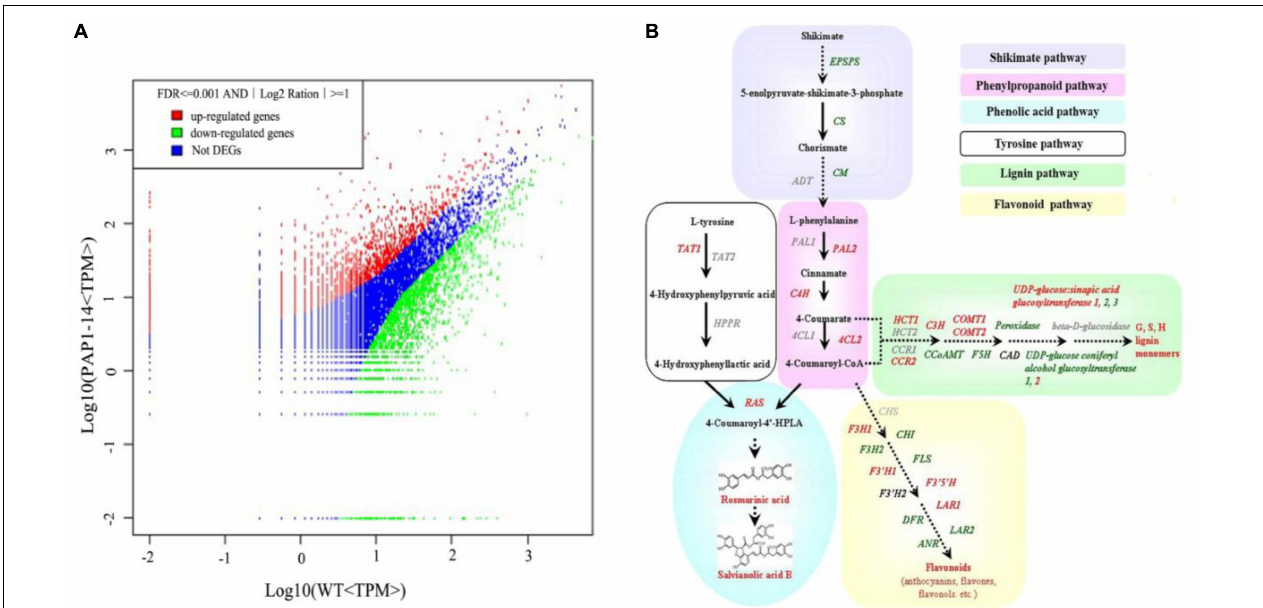
FIGURE 1 | Transcriptome response of Salvia miltiorrhiza to overexpression of AtPAP1 . (A) Comparison of gene expression between two libraries, with each normalized to one million tags. Red dots represent transcripts more prevalent in AtPAP1-14 library; green dots, those present at lower frequency in transgenic plants; and blue dots, transcript levels with no significant change. Parameters “FDR < 0.001” and “log 2 Ratio ≥ 1” were used as threshold to judge significance of differences in expression. (B) Proposed biosynthetic pathway for phenolics, beginning with core phenylpropanoid and tyrosine pathways, and leading to three major branch pathways: phenolic acid, flavonoid, and lignin (red, upregulated genes; green, downregulated). TAT, tyrosine aminotransferase; HPPR, hydroxyl phenylpyruvate reductase; PAL, phenylalanine ammonia lyase; C4H, cinnamate 4-hydroxylase; 4CL, hydroxycinnamate-CoA ligase; RAS, rosmarinic acid synthase; CYP, cytochrome P450 enzymes; CHS, chalcone synthase; CHI, chalcone isomerase; FLS, flavonol synthase; F3H, flavanone 3-hydroxylase; F3’H, flavonoid 3’-hydroxylase; F3 (cid:48) 5 (cid:48) H, flavonoid 3 (cid:48) ,5 (cid:48) -hydroxylase; DFR, dihydroflavonol 4-reductase; ANS, anthocyanin synthase; HCT, hydroxyl cinnamoyl transferase; CCR, cinnamoyl-CoA reductase; C3’ H, coumarate 3’-hydroxylase; COMT, caffeic acid O -methyltransferase; CCoAMT, caffeoyl-CoA O -methyltransferase; F5H, ferulate 5-hydroxylase; GT, glycosyltransferase; CAD, cinnamyl alcohol